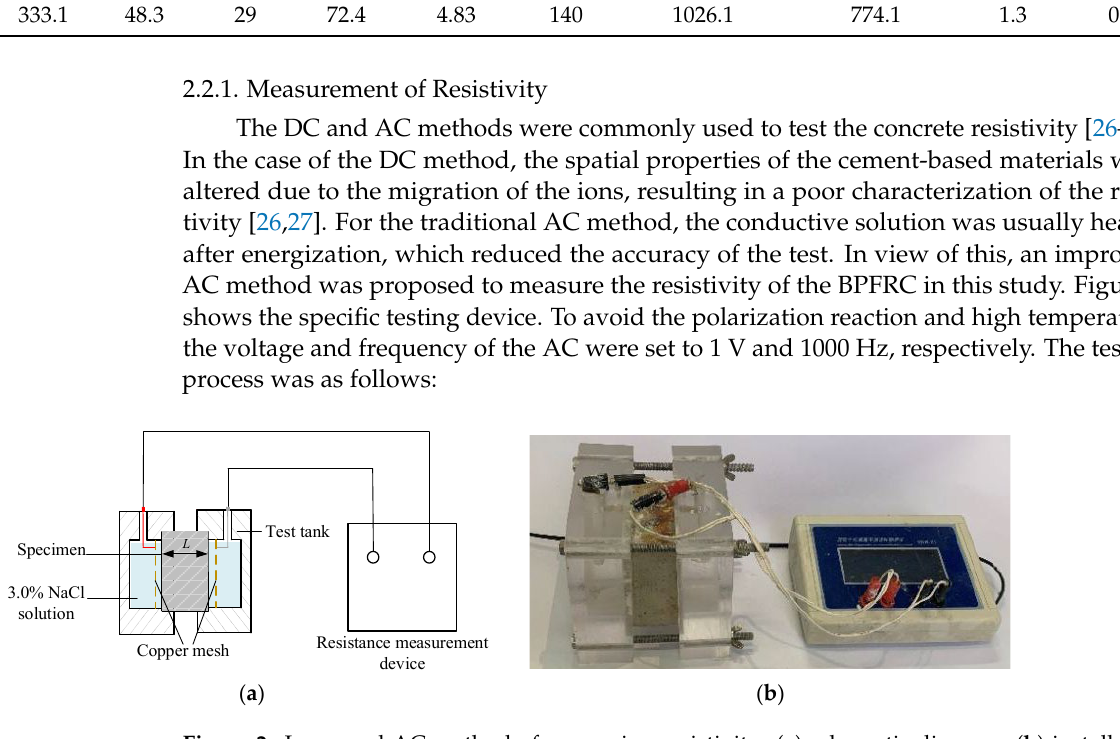
Figure 2. Improved AC method of measuring resistivity: ( a ) schematic diagram; ( b ) installation diagram.